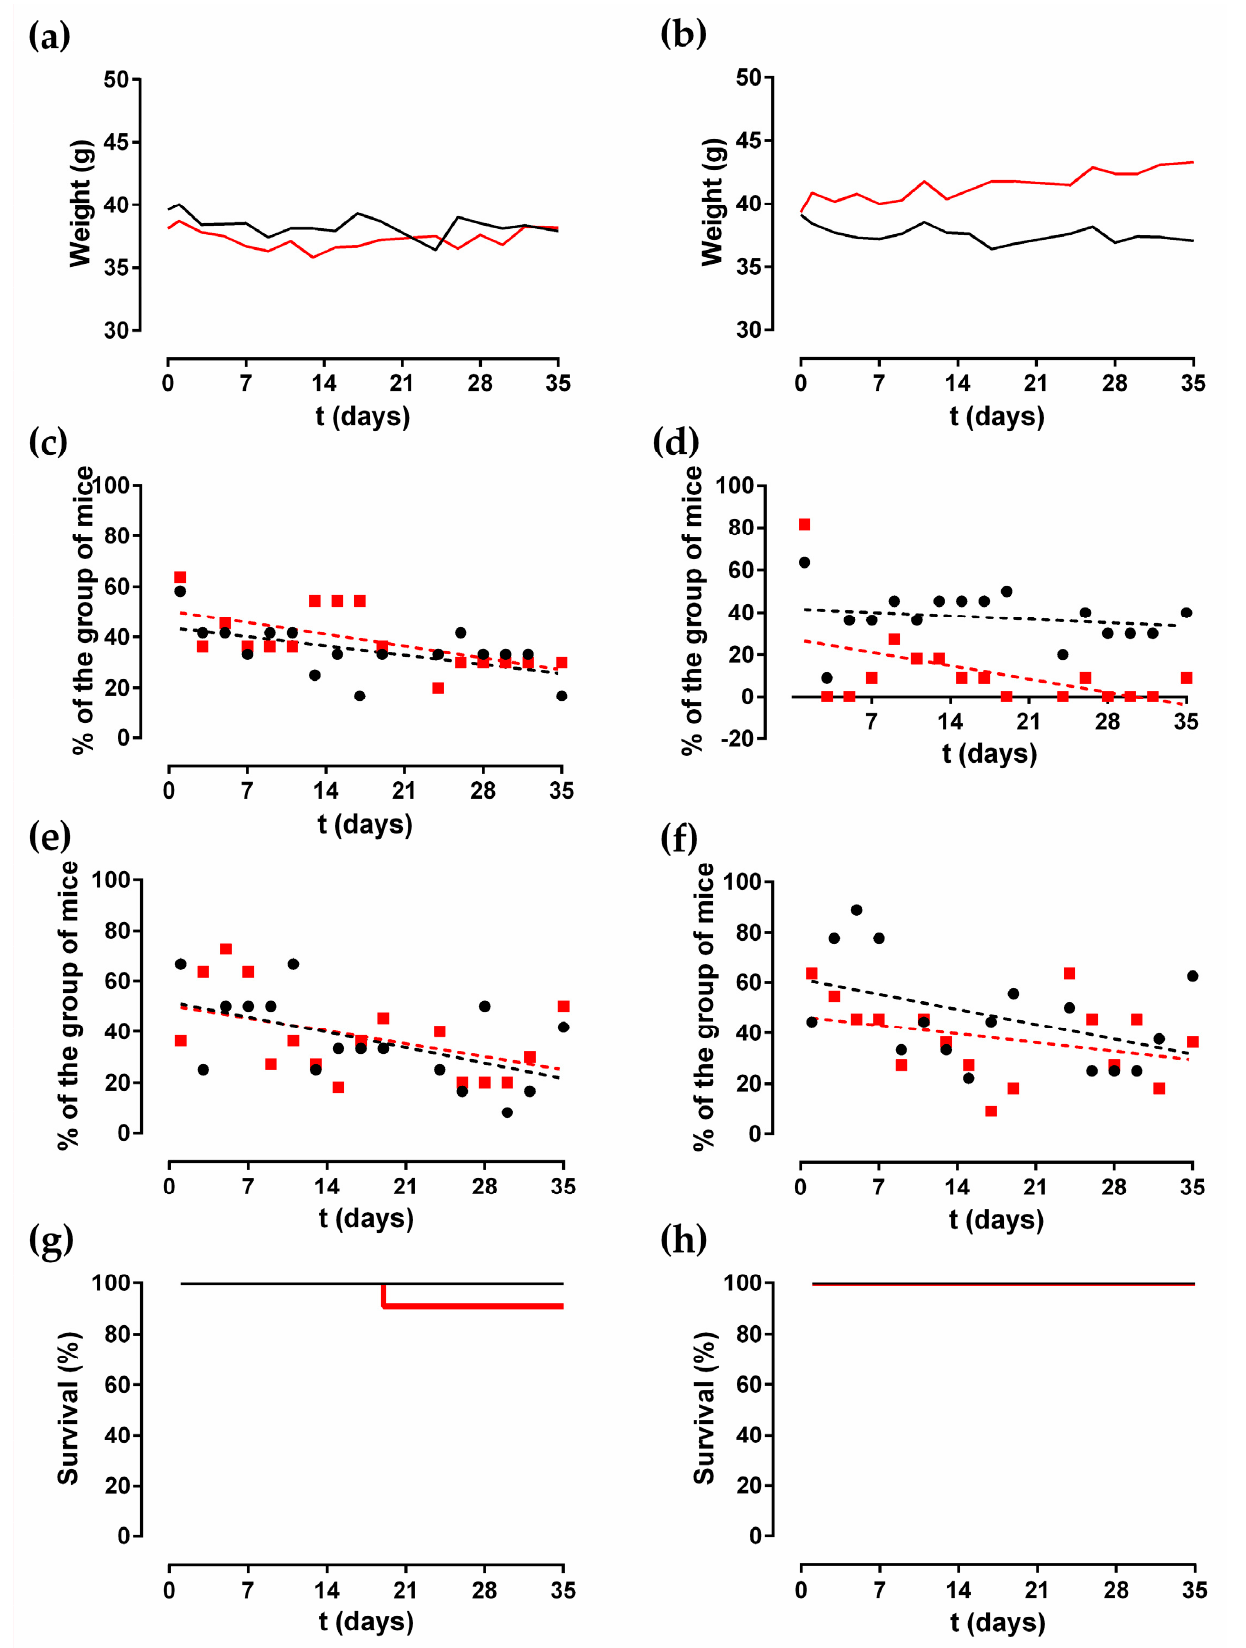
Figure 1. Median weight ( a , b ), limping ( c , d ), piloerection ( e , f ), and survival ( g , h ) in different noninfected groups (black) and in the Cal 35-infected group (red) with insertion of CP (left column) and CP+A implant (right column) over time. In the groups of animals with CP implants, only the noninfected group showed a significant decrease in piloerection over time ( p = 0.031), with a slope of − 0.8635% per day (Figure 1e). In the mice with an inserted CP+A-implant, piloerection stayed constant over time in both groups (Figure 1f). Survival was significantly lower in the Cal35-infected group with CP implants than in the noninfected group as of day 19 ( p = 0.002) (Figure 1g). Only one mouse (9.1%) in the Cal35-infected group with CP implants died of candidemia (Figure 2). Only one mouse in